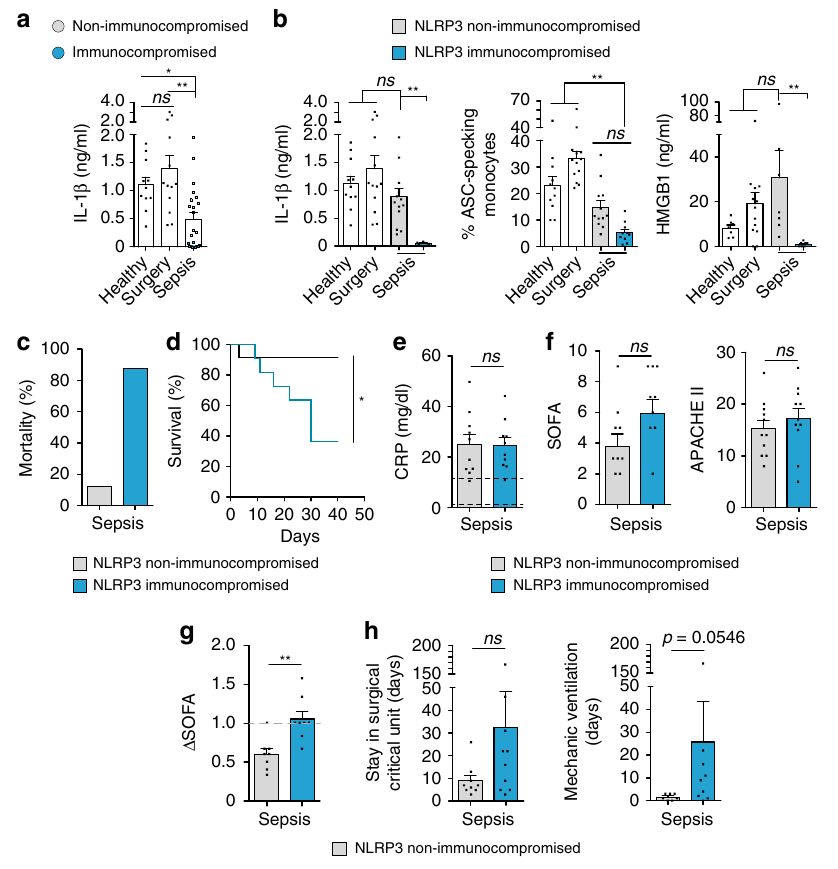
Fig. 2 In fl ammasome activation is compromised in septic patients with high mortality. a ELISA for IL-1 β in PBMC supernatants and percentage of monocytes with intracellular ASC specks from septic patients within the fi rst 24 h of admission to the surgical critical unit and control groups after NLRP3 in fl ammasome activation by LPS (1 μ g/ml, 2 h) and ATP (3 mM, 30 min) treatment. There is a group of septic patients that release low or no IL-1 β (blue dots). b ELISA for IL-1 β and HMGB1 in PBMC supernatants and percentage of monocytes with intracellular ASC specks from control groups and septic patients treated as in a , separating septic patients into two groups: NLRP3 non-immunocompromised (gray bar) and immunocompromised (blue bar). c Percentage of mortality in NLRP3 non-immunocompromised (gray bar) and immunocompromised (blue bar) septic patients with regard to the total mortality of septic patients. d Kaplan – Meier representation of NLRP3 non-immunocompromised (gray line) and immunocompromised (blue line) septic patients ’ survival. e Concentration of C-reactive protein (CRP) in plasma of NLRP3 non-immunocompromised (gray bar) and immunocompromised (blue bar) septic patients at day 1; dotted lines represent threshold concentration of CRP for healthy population. f SOFA and APACHEII indexes in NLRP3 non- immunocompromised (gray bar) and immunocompromised (blue bar) septic patients at day 1. g Δ SOFA calculated as the variation in SOFA between day 5 and day 1, gray dotted line represents no change with regard to day 1. h Number of days admitted to the Surgical Critical Unit and number of days of mechanical ventilation for NLRP3 non-immunocompromised (gray bar) and immunocompromised (blue bar) septic patients. Each dot represents an individual patient; average ± standard error is represented in panels a , b , e – h ; exact n number for each panel is presented in Source Data fi le; * p <